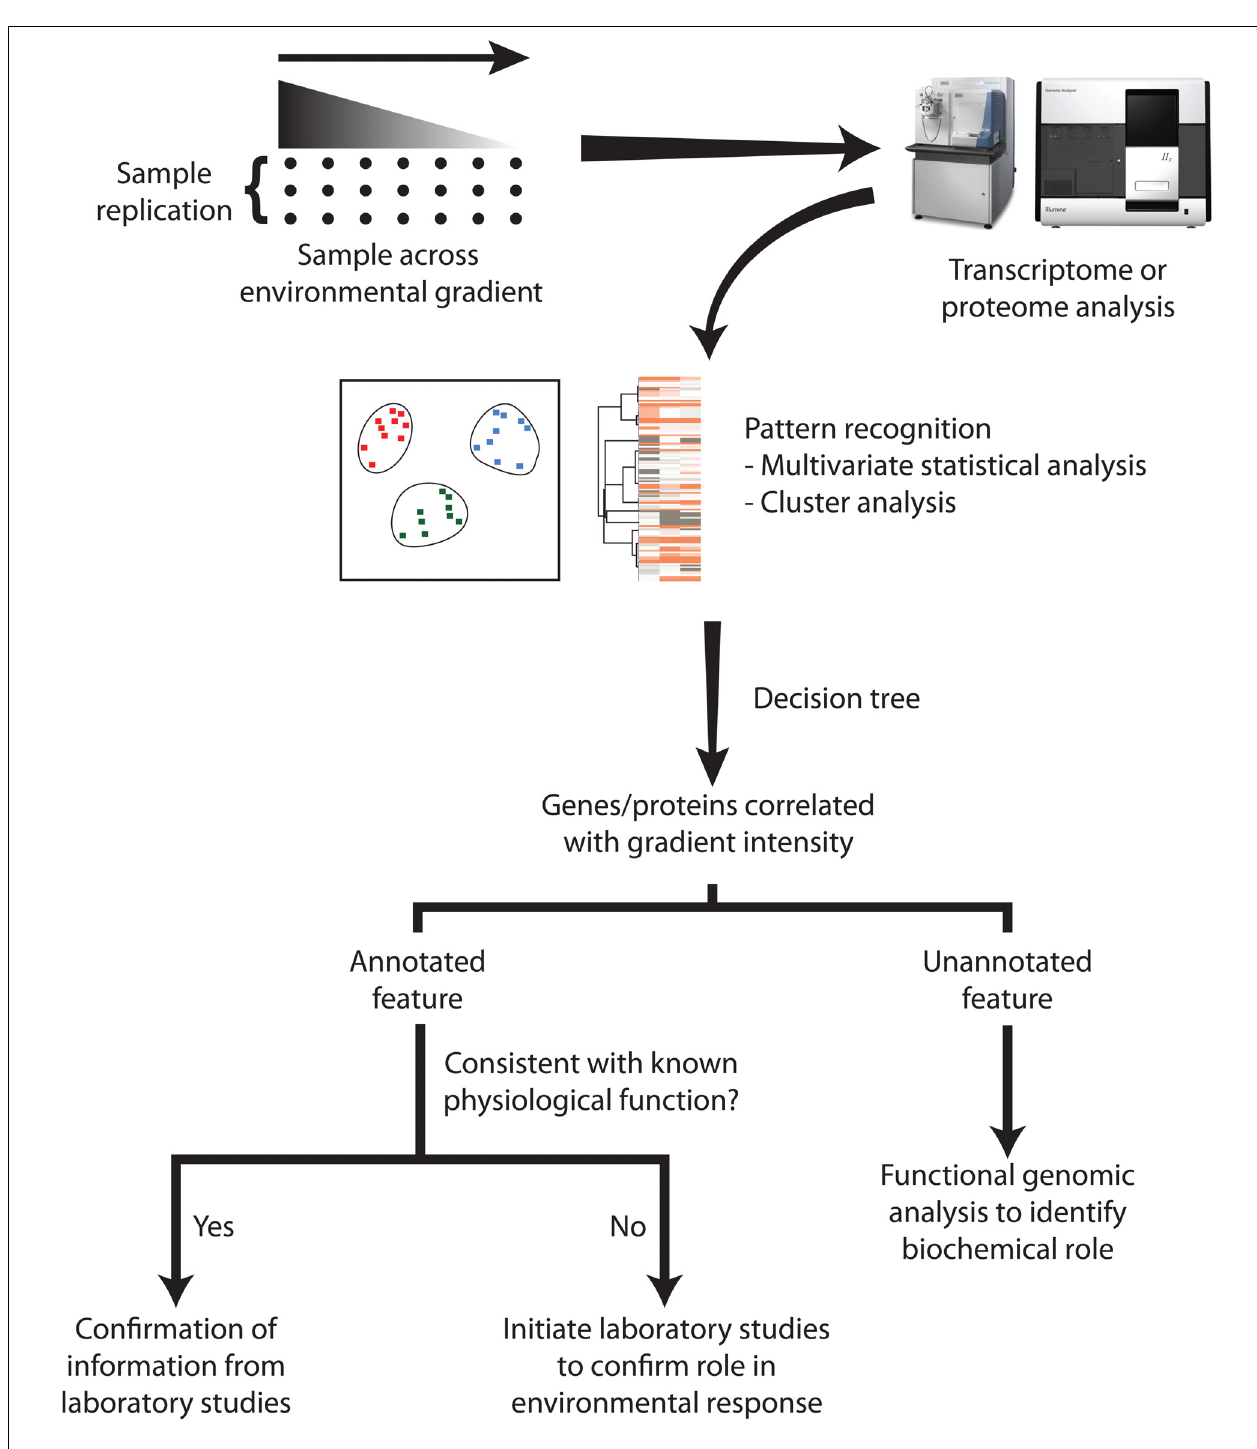
mining suggests that there is an annotated gene that has not previously been recognized as part of the adaptive response, laboratory experiments should be undertaken to confirm its role under well-controlled conditions. However, the most powerful outcome of this approach may be the identification of unannotated genes that contribute to specific physiological adaptations.This generates a motivation for detailed functional genomic analysis, and subsequent biochemical experimentation to elucidate its novel